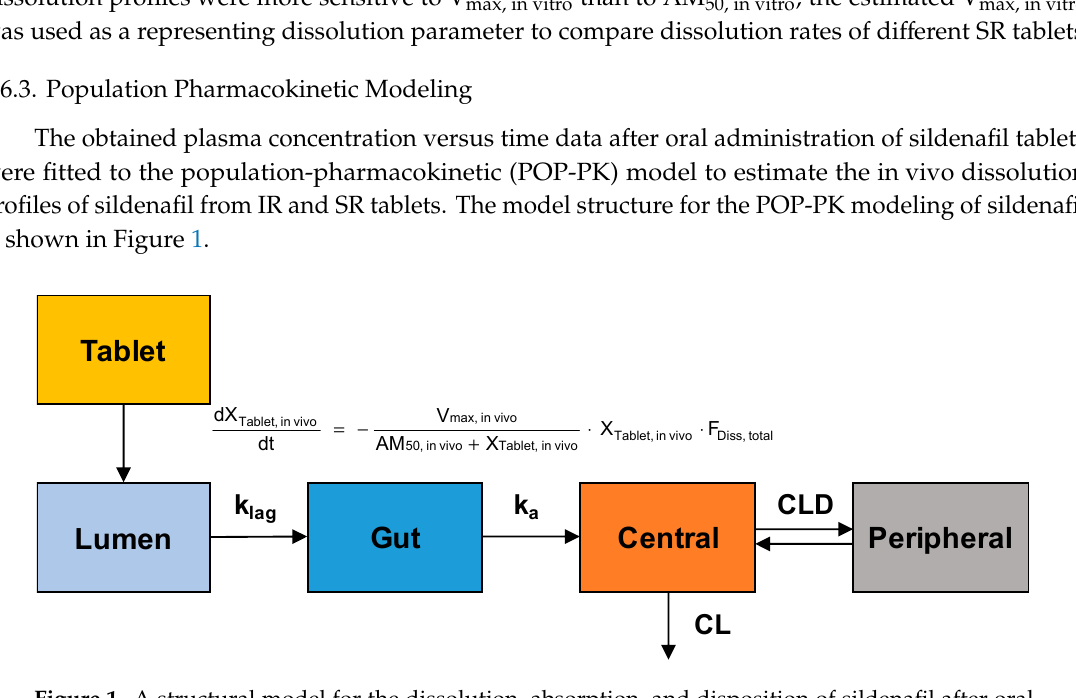
Figure 1. A structural model for the dissolution, absorption, and disposition of sildenafil after oral administration of sildenafil tablets. X Tablet, in vivo , the amount of drug in the tablet; V max, in vivo , in vivo maximum dissolution rate; AM 50, in vivo , the amount of drug at which the dissolution rate is half of V max, in vivo ; F Diss, total , the dissolved fraction that can change over time; k lag , the first order rate constant representing the transfer of the dissolved sildenafil from the lumen to the gut compartment; k a , first-order absorption rate constant; CL, systemic clearance; CLD, distribution clearance.